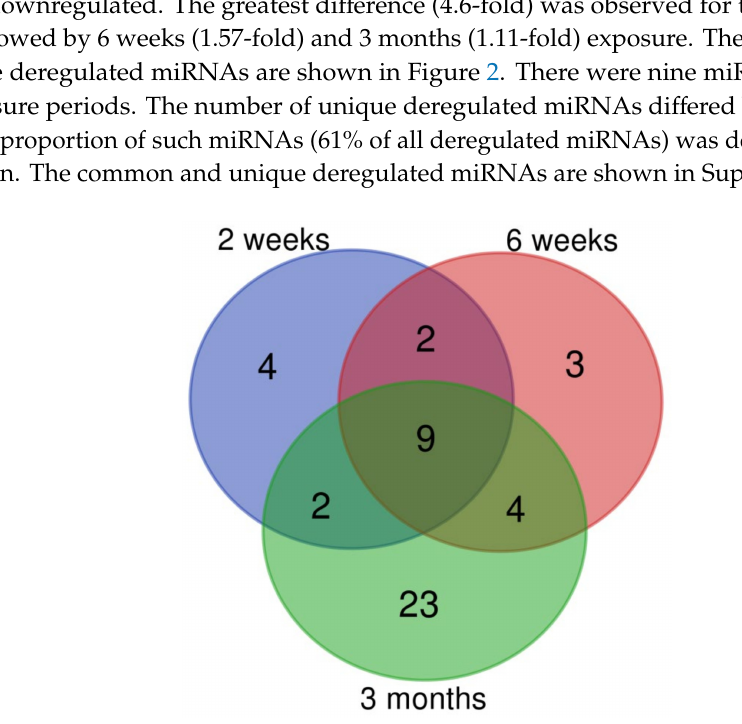
Figure 2. The numbers of common and unique miRNAs deregulated after CuO NPs